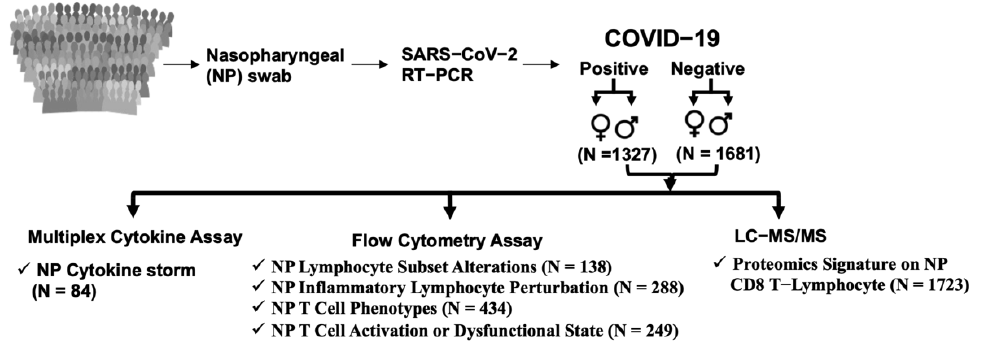
Figure 1. Overview of the nasopharyngeal (NP) data collection and immune perturbations associated with severe COVID-19 analysis